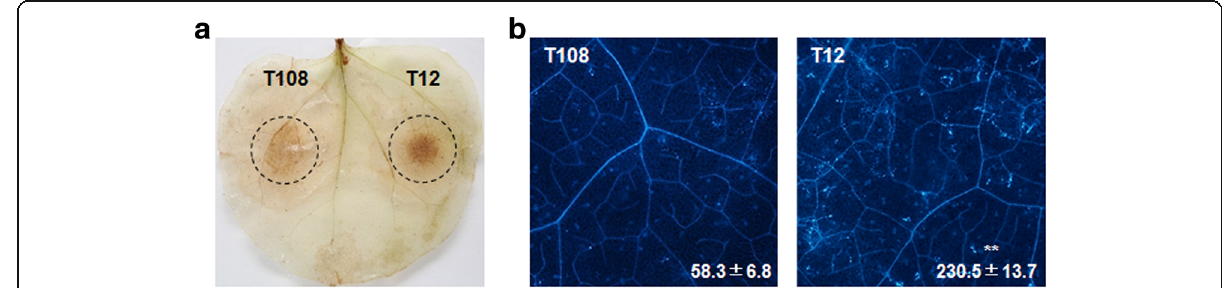
Fig. 6 RxLR48 contributes to suppression of PTI-related immune responses. a H 2 O 2 accumulation during Phytophthora capsici infection. RxLR48- non-silenced transformant T108 (control) and silenced transformant T12 were inoculated on Nicotiana benthamiana detached leaves. DAB staining was performed at 9 hpi. The black dashed circle indicates inoculation sites. b Callose deposition after P. capsici infection. Detached leaves of N. benthamiana were inoculated as described above and then stained by aniline blue at 12 hpi. Values of callose deposition shown were quantitated by using ImageJ software (mean ± SD; n ≥ 6; **, P < 0.01, Student ’ s t